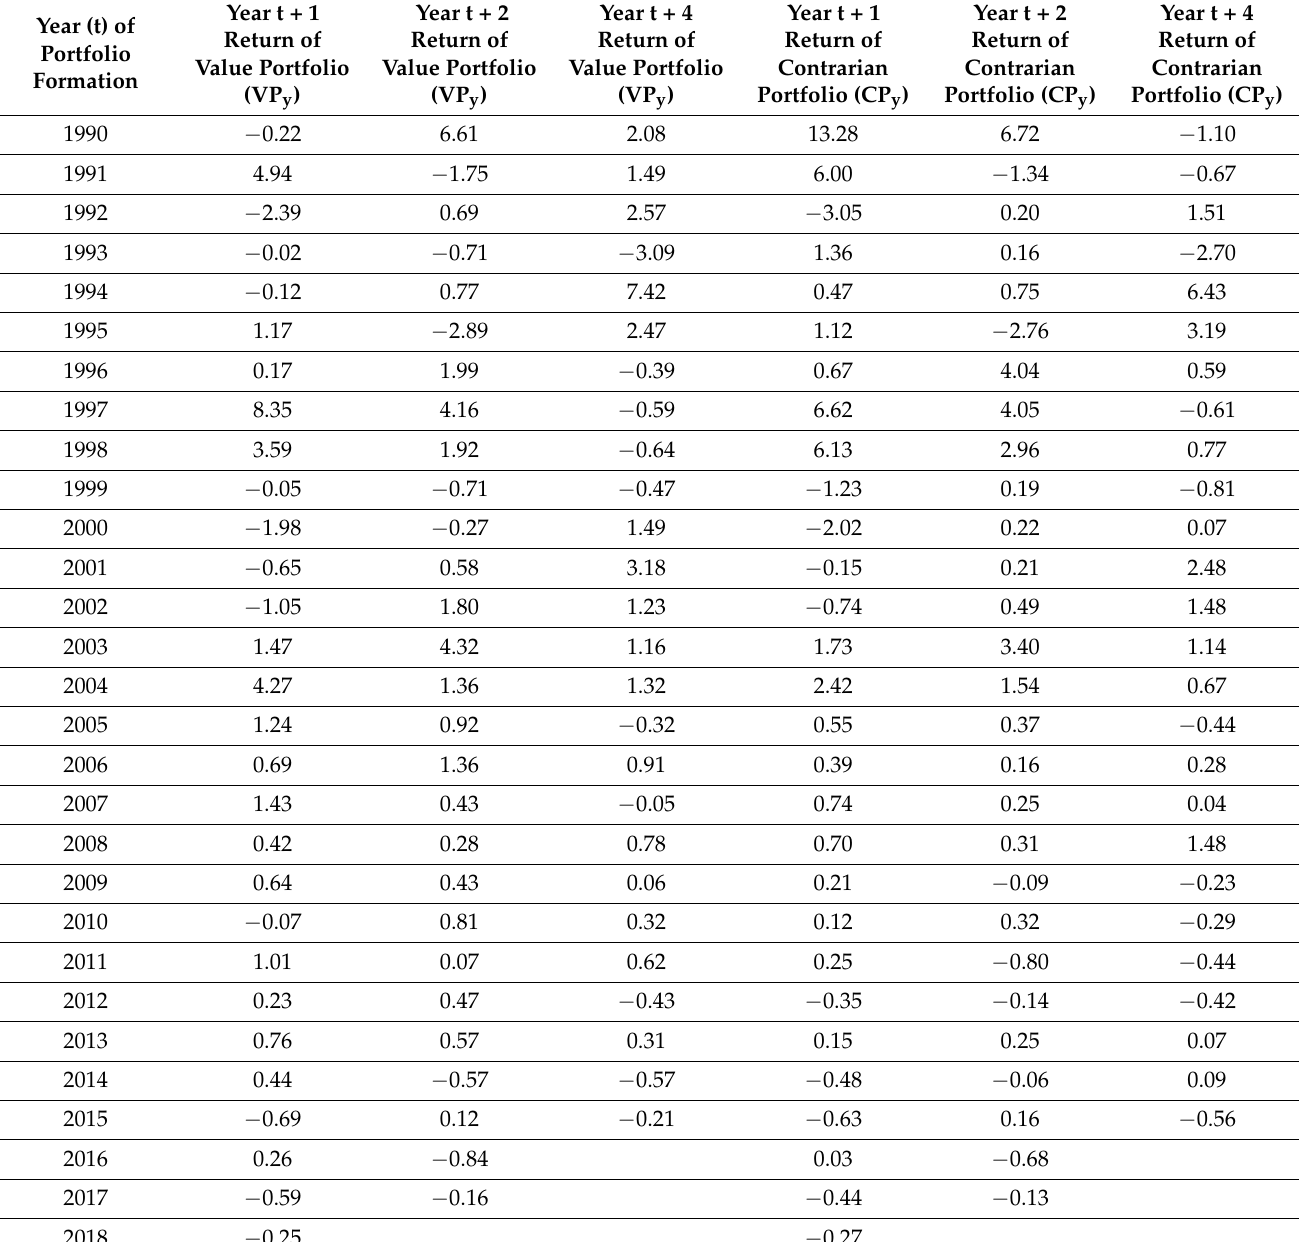
Table 2. Return of value portfolio (VP y ) and contrarian portfolio (CP y